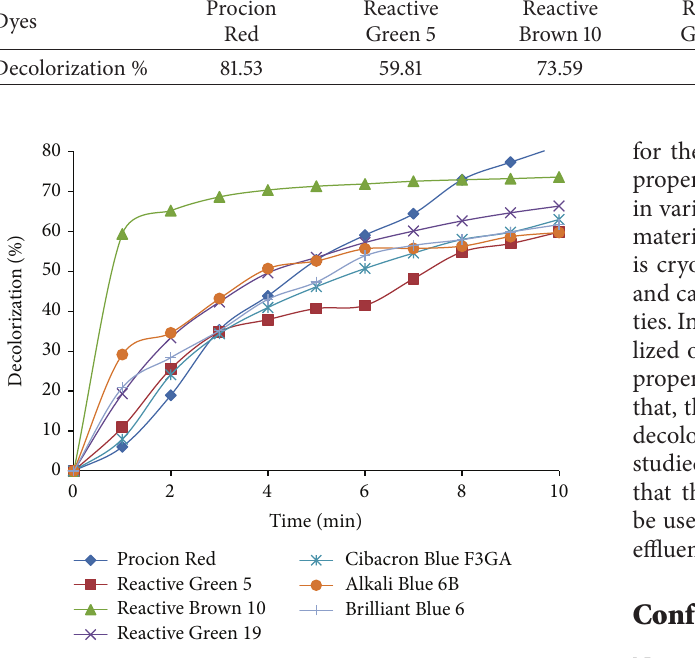
Figure 9: Decolorization efficiency of immobilized laccase onto poly(MMA- co -GMA)